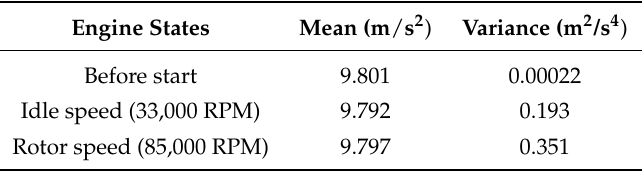
Table 1. Mean and variance of acceleration